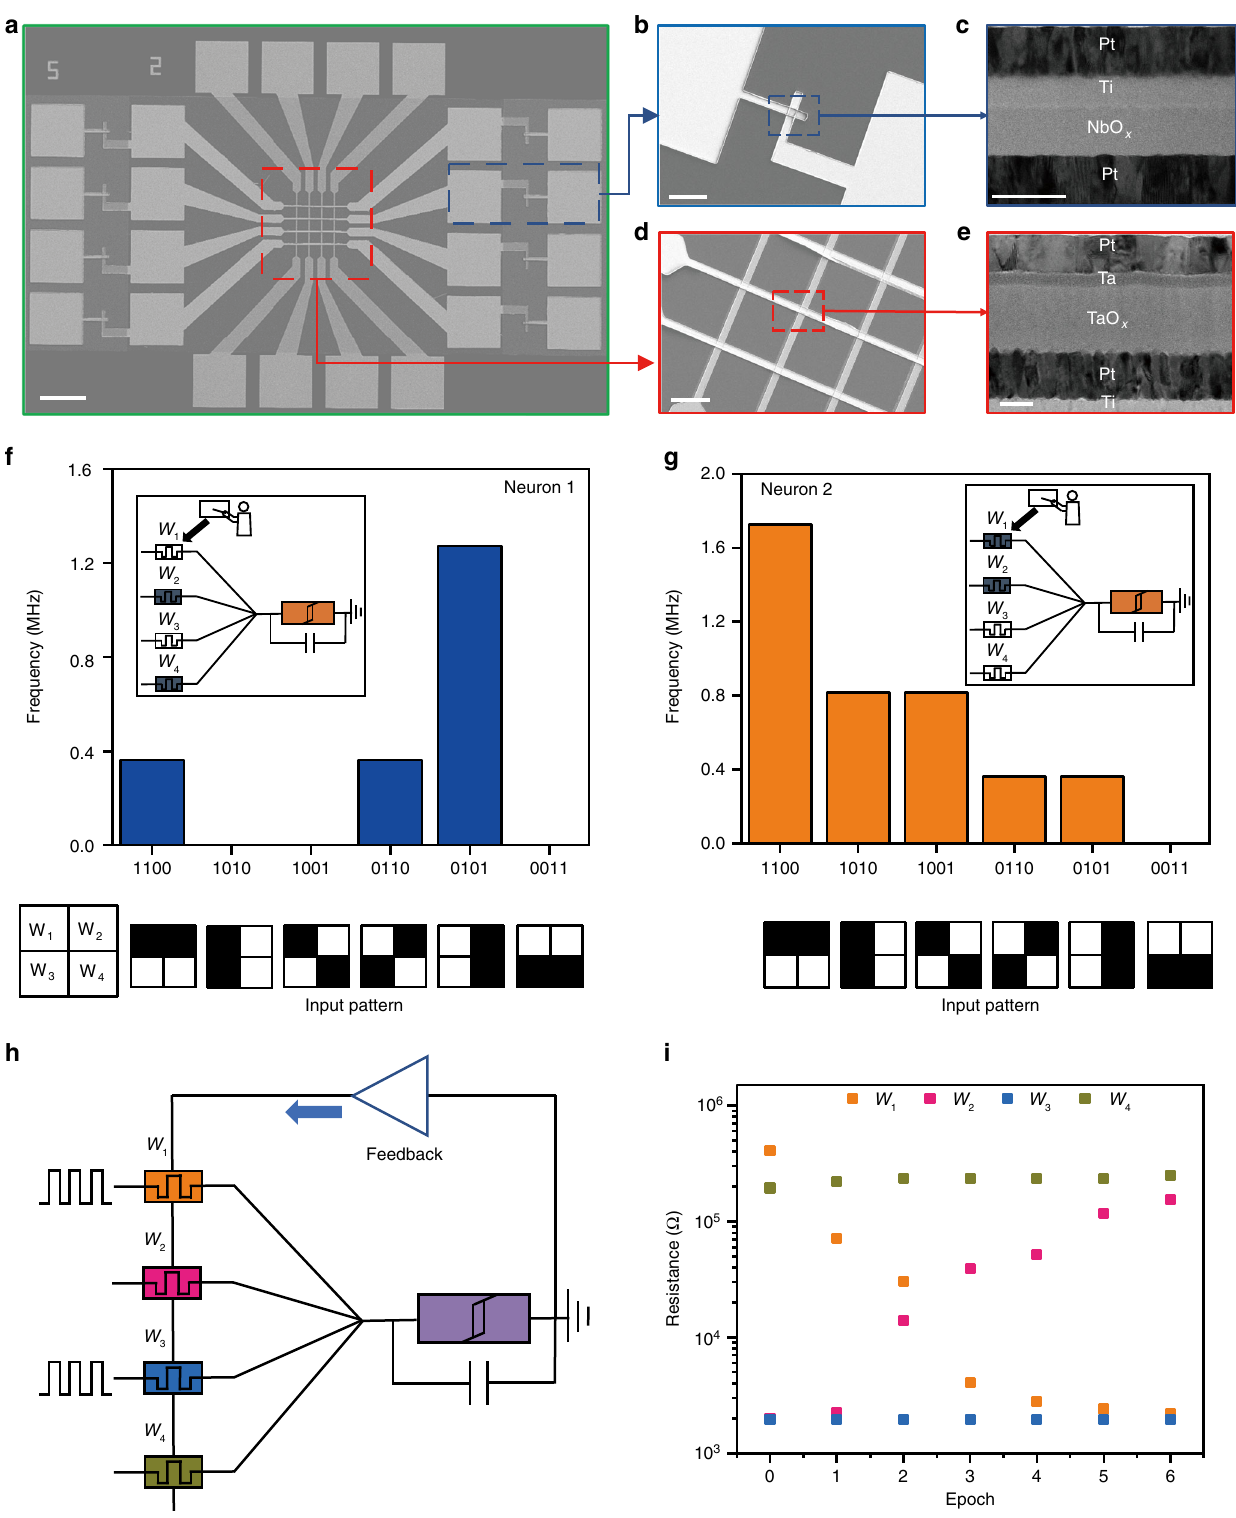
Fig. 5 Fully memristive spiking neural network. a Scanning electron microscopy (SEM) image of the monolithically integrated memristive neural network. Scale bar, 100 μ m. b SEM image of the Pt/Ti/NbO x /Pt threshold switching device. Scale bar, 20 μ m. c Cross-sectional transmission electron microscopy (TEM) image of the Pt/Ti/NbO x /Pt threshold switching device. Scale bar, 50 nm. d SEM image of a Pt/Ta/TaO x /Pt synapse device. Scale bar, 10 μ m. e Cross-sectional TEM image of the Pt/Ta/TaO x /Pt device. Scale bar, 20 nm. f , g Neuronal outputs when presented with different input patterns. f Neuron 1 learnt to recognize pattern “ 0101 ” , while neuron 2 learnt to recognize pattern “ 1100 ” g . The input pulses are 1 V in amplitude, 1 μ s in width, 0.1 μ s in interval and repeated for 10 cycles. h Schematic illustration of supervised learning in a fully memristive neural network. i Evolutions of synaptic weights over time during online learning, where the pattern “ 1010 ” is repeatedly applied, with an initial state of “ 0110 ”